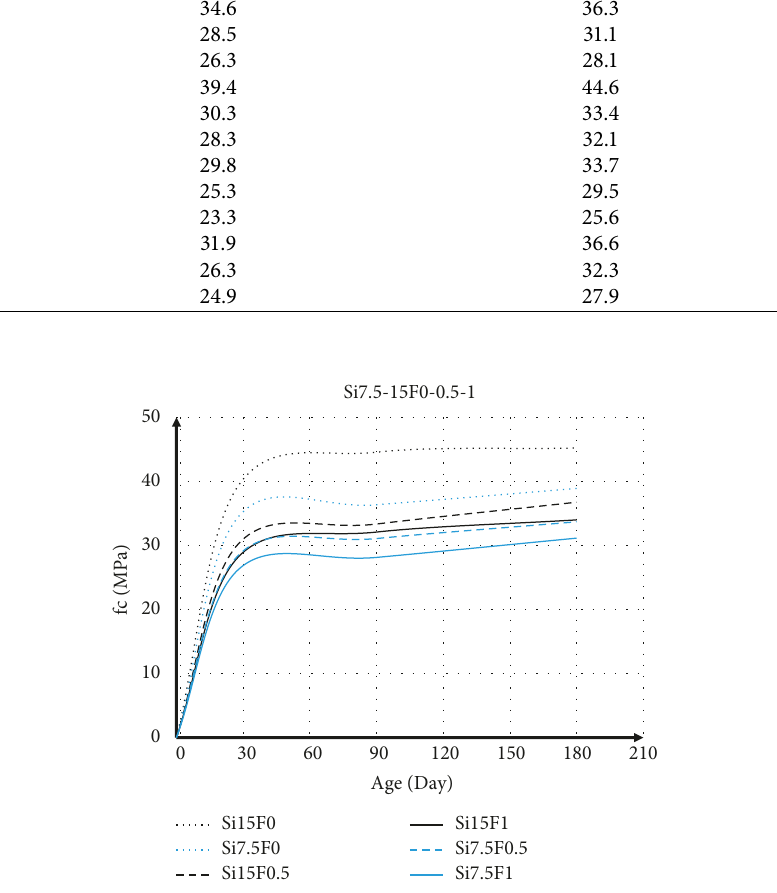
Figure 6: The compression of green concrete compressive strength containing zeolite with/without MPW fiber.